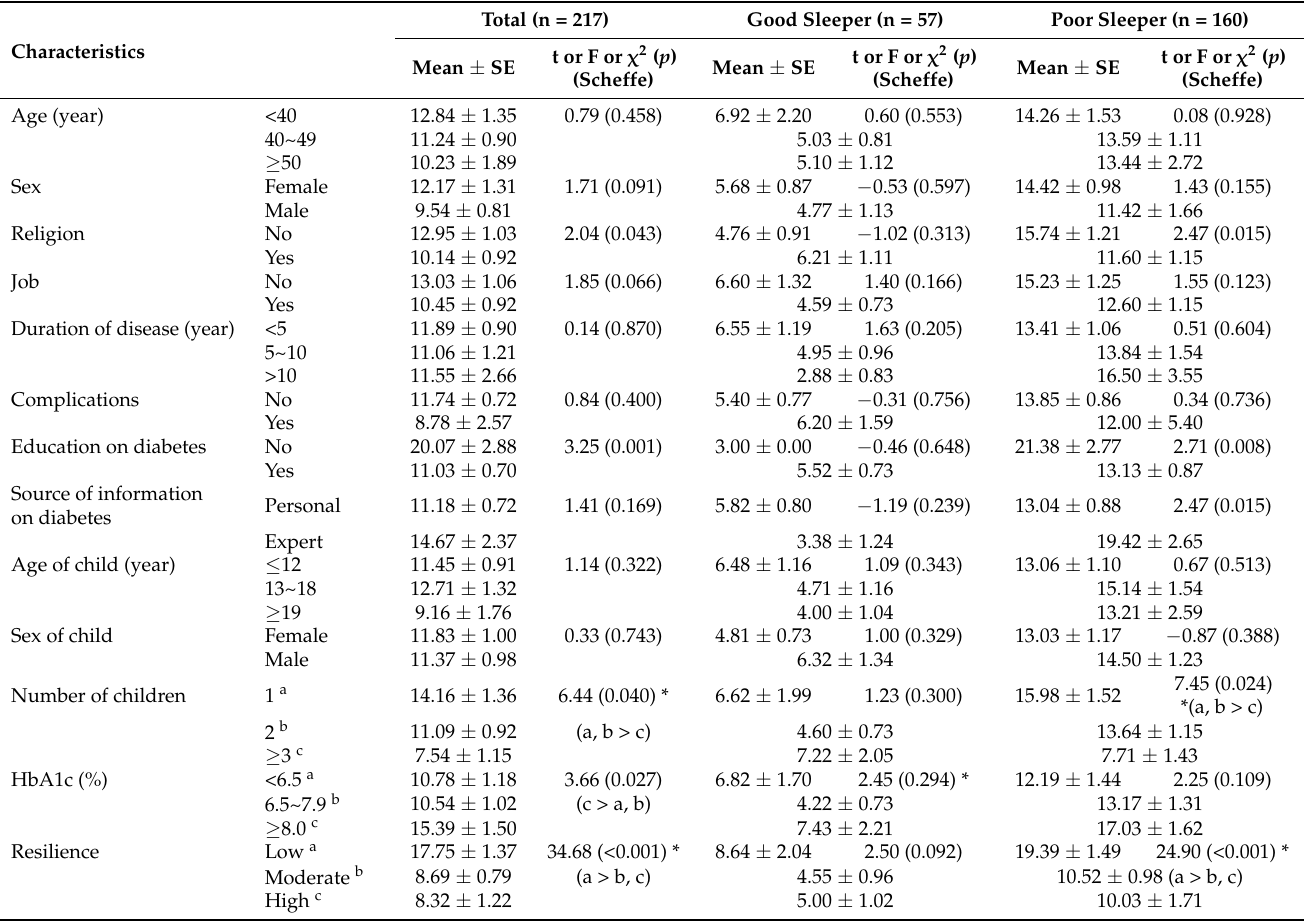
Table 3. Depression According to Participant Characteristics (n =